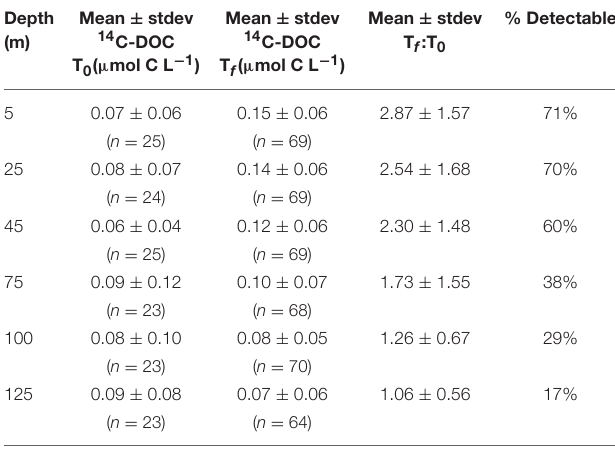
The percent detectable indicates the proportion of the T f samples that were greater than three times the standard deviation of the mean T 0 (defined as the limit of detection). Incubation times for T f measurements ranged from 11 to 13h (full photoperiod). Shown in parentheses are number of measurements (n) used to compute means.